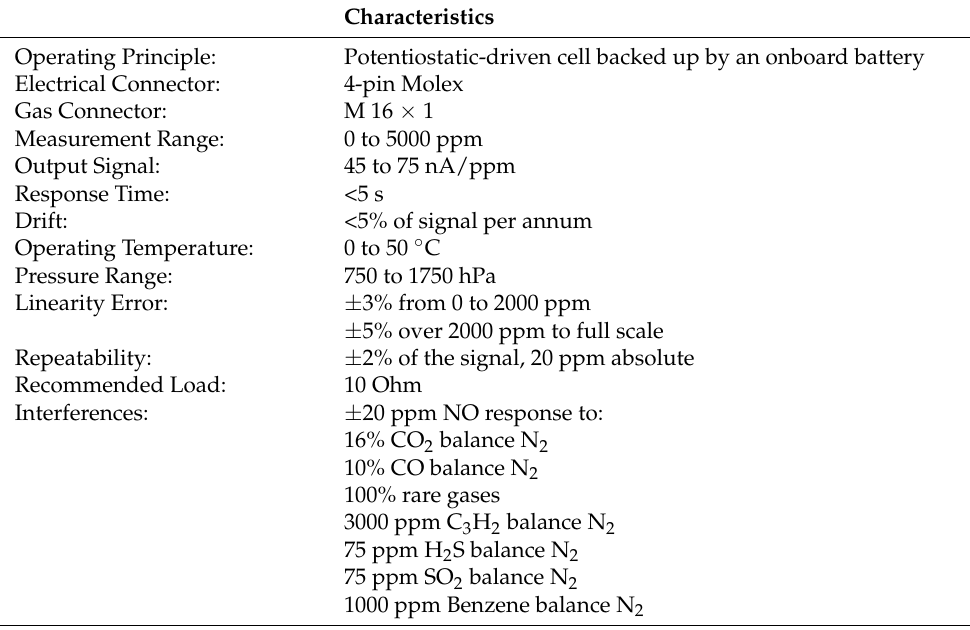
Table A4. Tekber electrochemical NO x sensor Technical Characteristics (Source: Tekber).